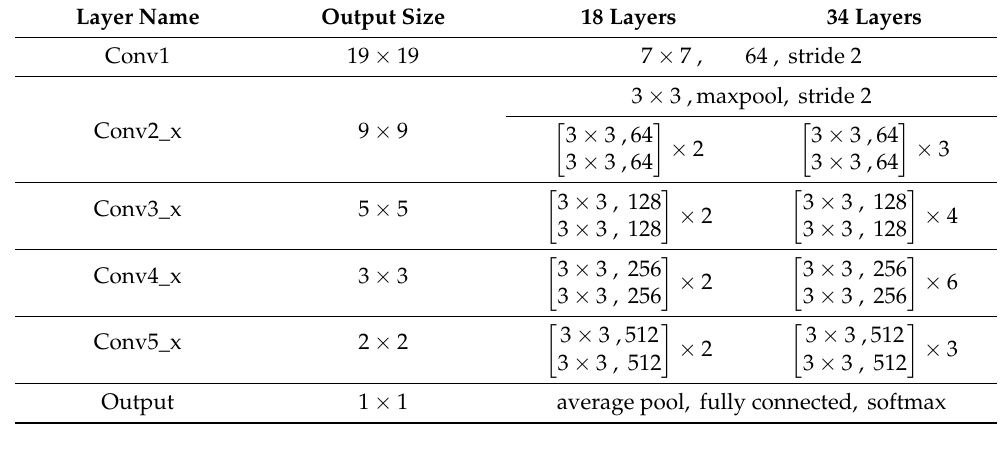
Table 2. Detailed architecture of 18 convolutional layer baseline and 34 convolutional layer base- line models.